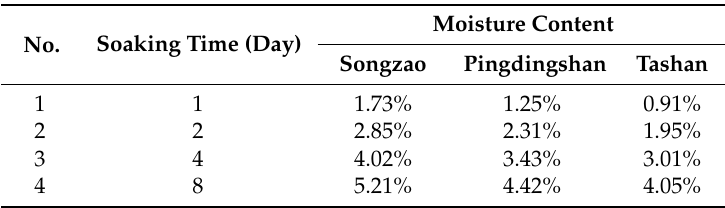
Table 2. Moisture content controls.